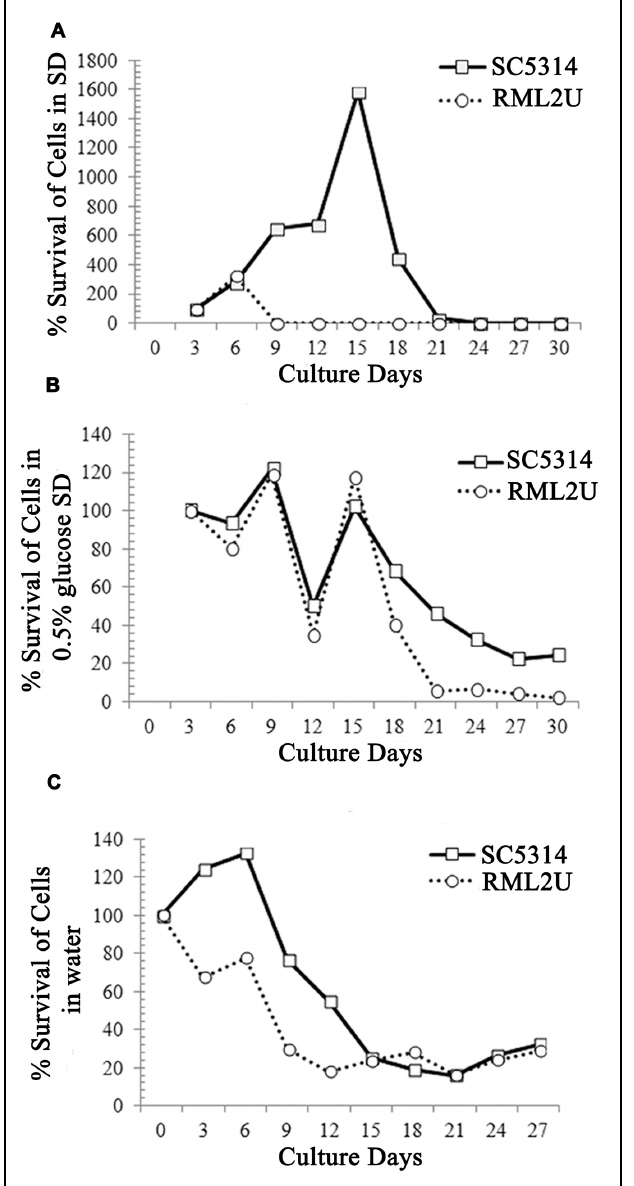
FIGURE 6 | Ecm33 possitively influences the chronological life span of C. albicans . (A) SC5314 and RML2U were logarithmically growth in SD medium at 30 ◦ C. Samples were taken at the indicated times to determine CLS, as described in Section “Materials and Methods.” (B) CLS under calorie restriction by glucose reduction (0.5% glucose SD). (C) Extreme calorie restriction in which cultures were transferred to water on day 3 further extends the life span of RML2U.